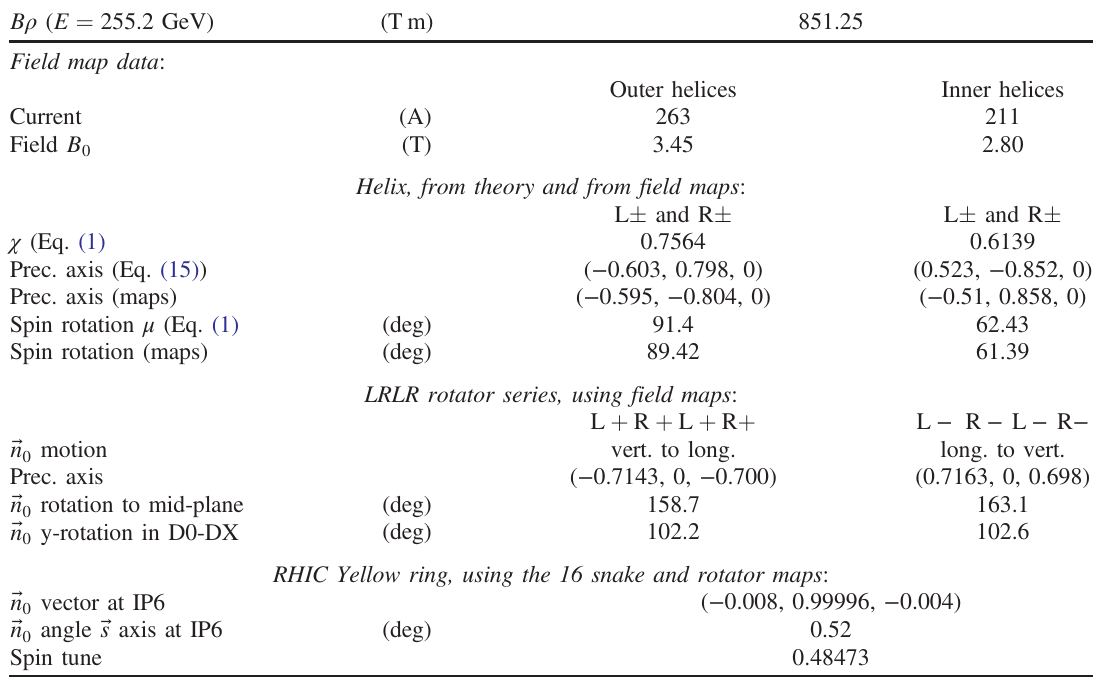
TABLE V. Spin parameters of RHIC Yellow rotator 360°-twist helix, of the LRLR series, and of RHIC ring, including precession axes, “ prec. axis ” (radial, longitudinal, vertical). Data listed are either from theory or from simulations using field maps, as specified.